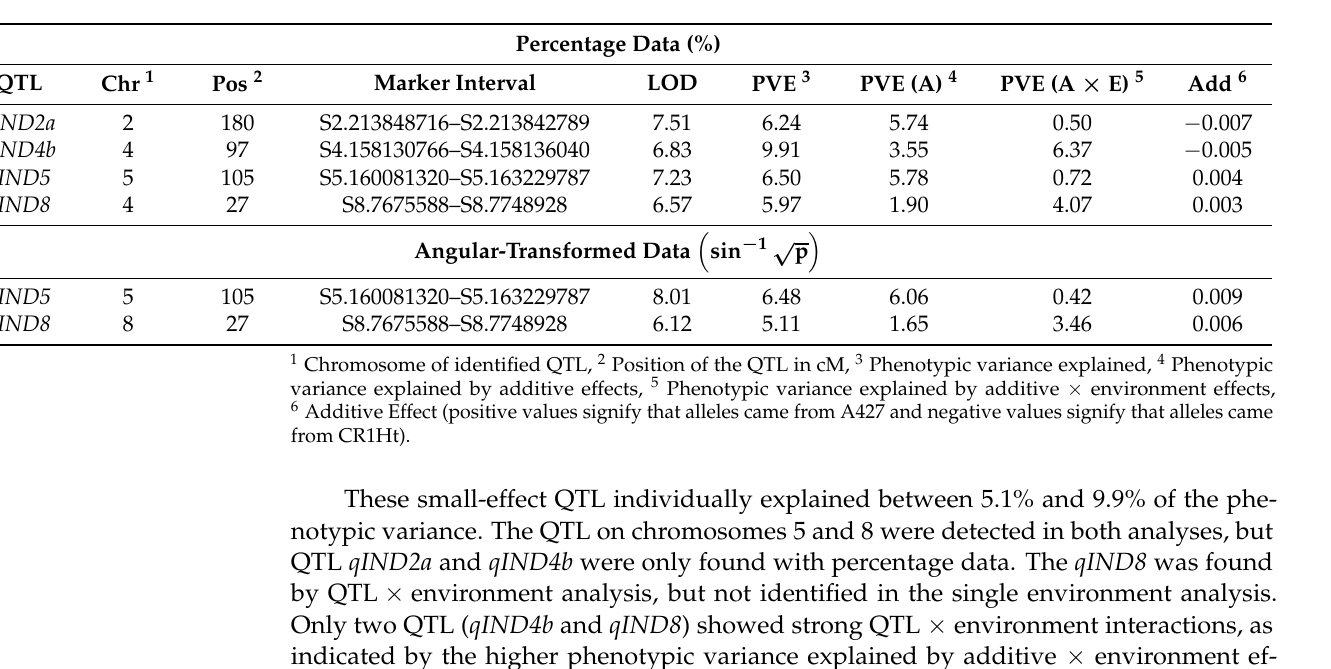
Table 4. QTL × environment interactions in three environments for inducibility using percentage and angular-transformed